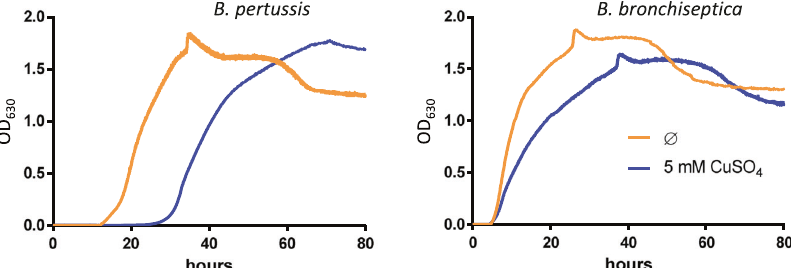
Fig. 1 Effect of copper on B. pertussis and B. bronchiseptica growth. Growth curves of B. pertussis BPSM and B. bronchiseptica RB50 in SS medium supplemented (blue curves) or not (orange curves) with 5 mM CuSO 4 are shown. The turbidity of the cultures was measured using an Elocheck device. The values shown in ordinate (absorbency units) do not correspond to optical density measurements classically obtained with a spectrometer, since the Elocheck instrument uses distinct pathlength and wavelength.